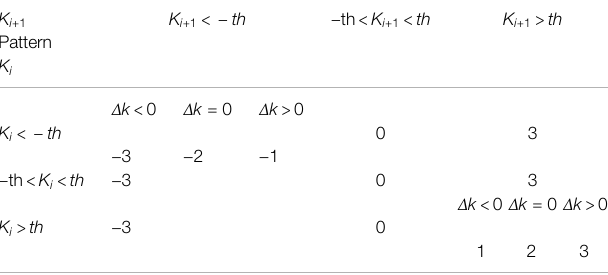
TABLE 2 | Shape distance schema